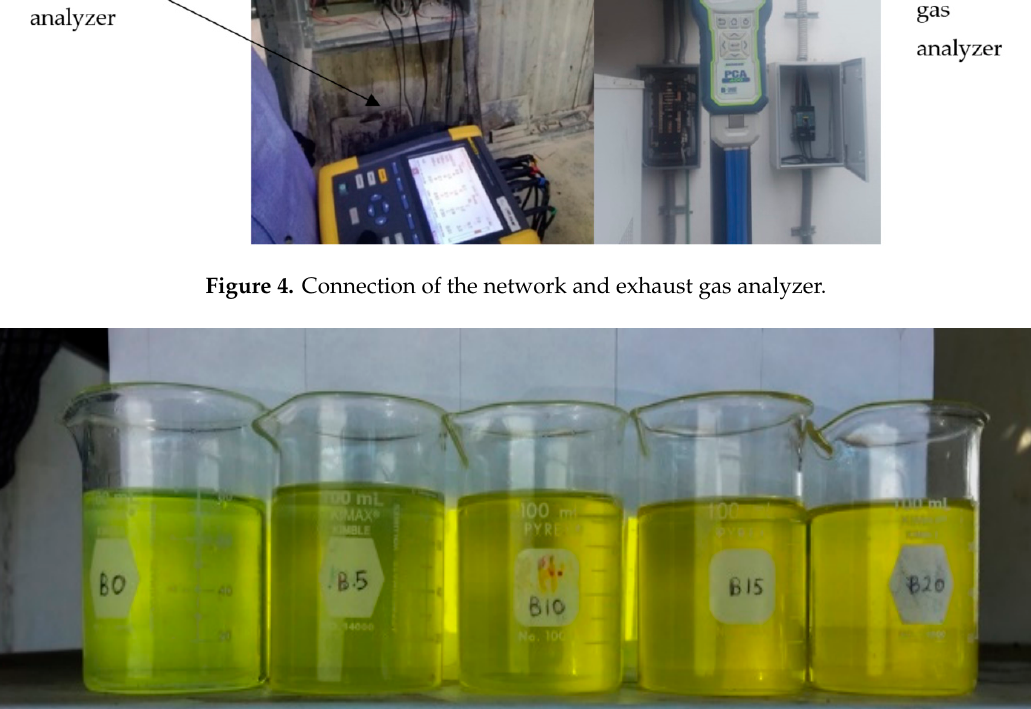
Figure 4. Connection of the network and exhaust gas analyzer.